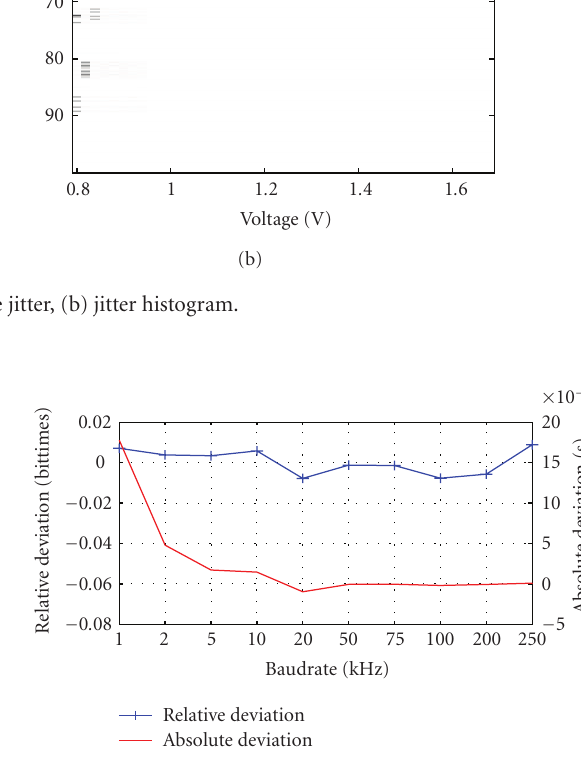
Figure 16: Mean relative/absolute deviation from optimum bit-